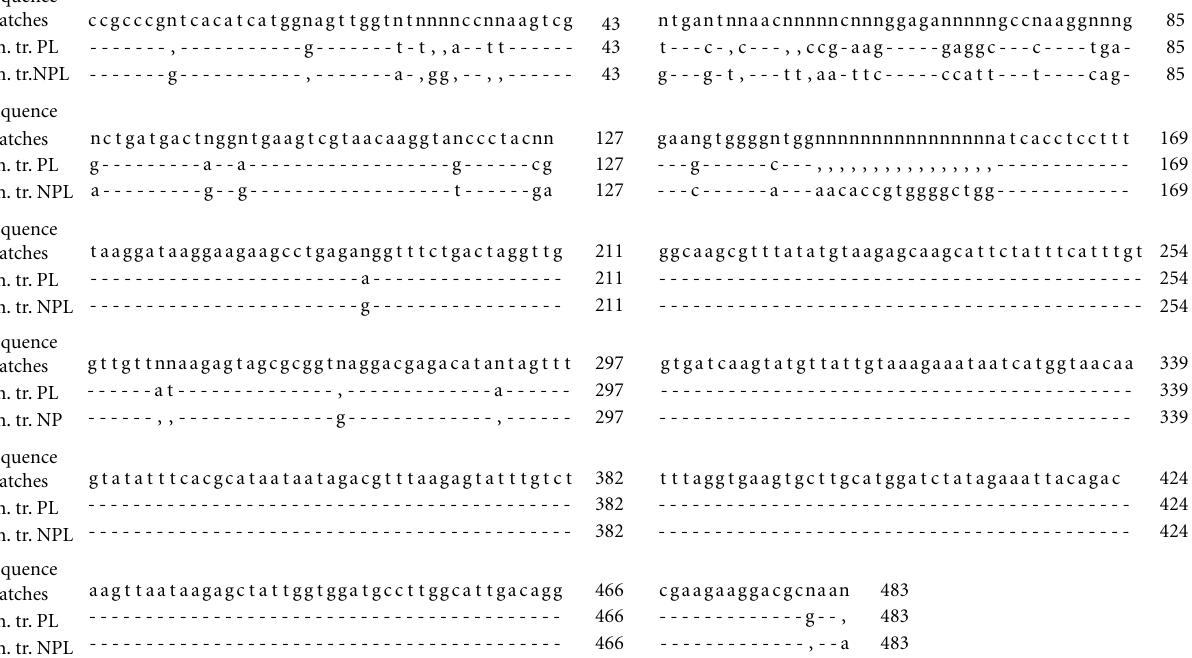
Figure 4: Comparative analysis of 16S–23S nucleotide sequence clusters of the middle ribosomal cluster and 23S rRNA I domain of plasmid (PL) and nonplasmid (NPL) Chlamydia trachomatis strains released from monkeys. ( - )—match of nucleotides in the sequence, (n)— mismatch of nucleotides in the sequence, (,)—absence of nucleotides in the sequence, (43-483)—nucleotide sequence size.